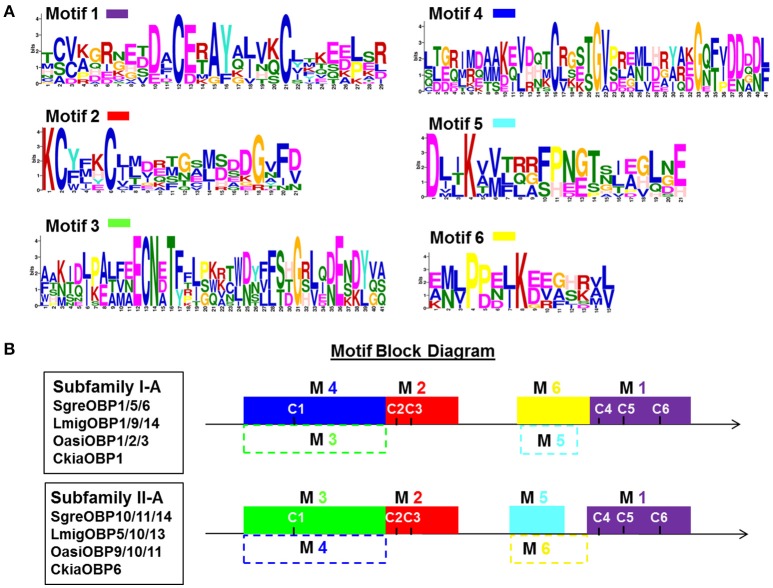
Identification and position of consensus amino acid motifs for subfamily I-A and II-A OBPs. (A) Six amino acid motifs with various widths were identified de novo to recapitulate the subfamily I-A and II-A OBP sequence signature (classification see Figure 1). The height of an amino acid character is proportional to the degree of conservation in the consensus sequences. (B) Position of identified consensus motifs (M1–M6) in the polypeptide chain of subfamily I-A and II-A OBPs. C1–C6 indicate the position of the conserved C-residues. Motif 1 and motif 2 adequately match the repertoire of OBP sequences in both subfamily I-A and II-A. In contrast, motifs combination M4 (blue) and M6 (yellow) specifically match subfamily I-A, whereas motifs M3 (green) and M5 (cyan) are specific for subfamily II-A OBP sequences. Dash lined blocks indicates unfitness of a particular motif to the target sequences (E-value above e−5; default statistical significant level). Obtained E-values for each motif are given in Figure S1.